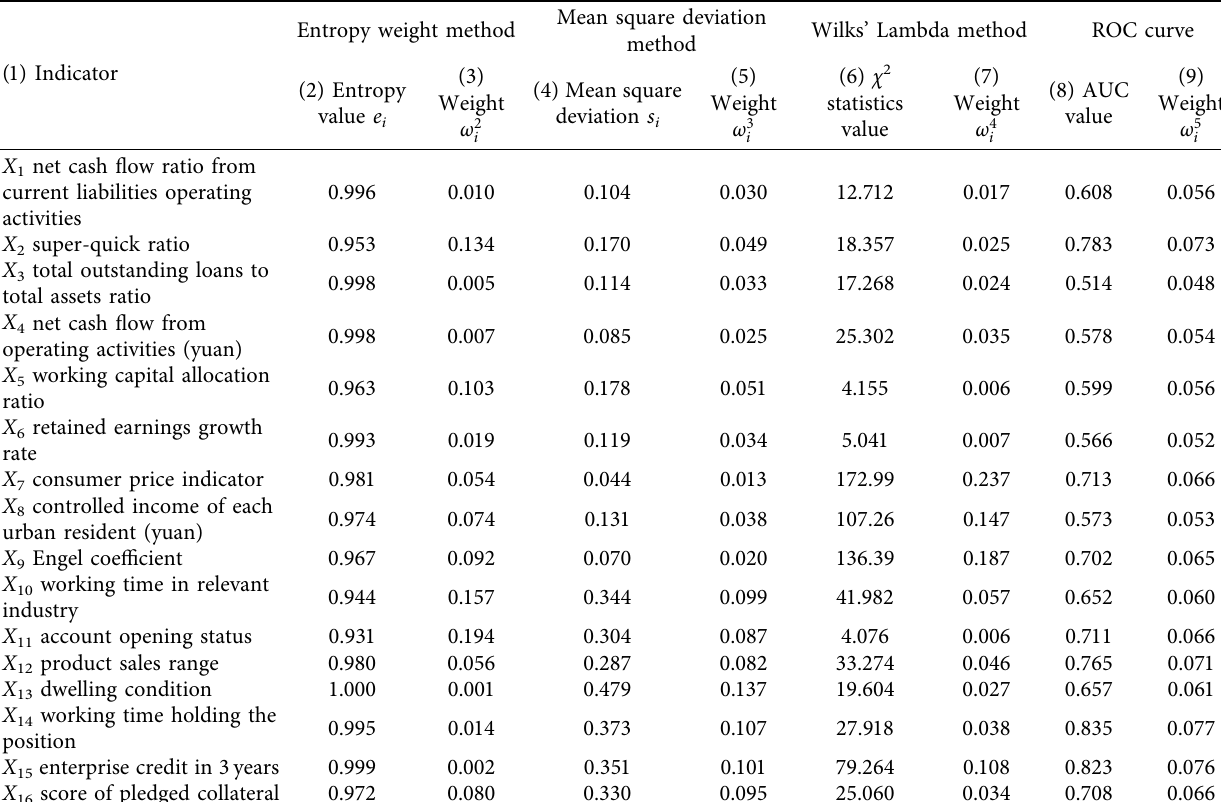
Table 7: The 4 types of objective weighting